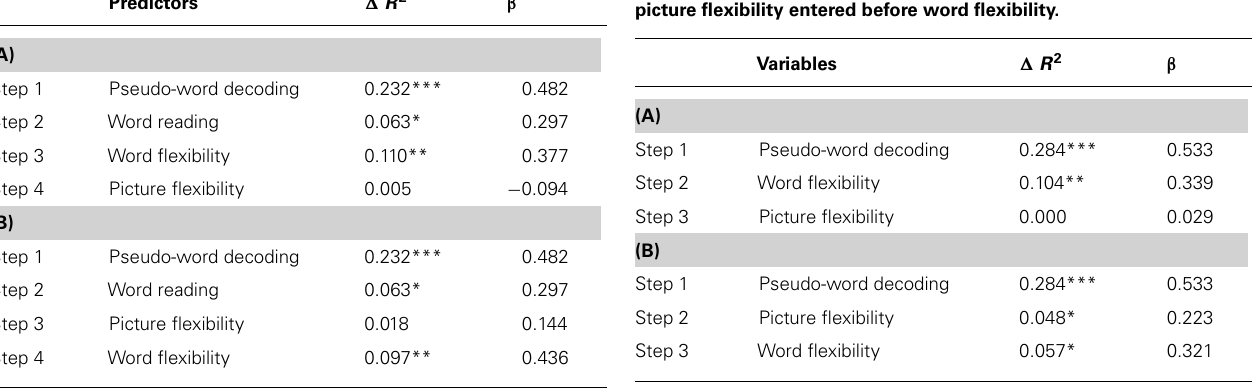
Table 3 | Hierarchical regression analyses predicting word reading with (A) word flexibility entered before picture flexibility; and (B) picture flexibility entered before word